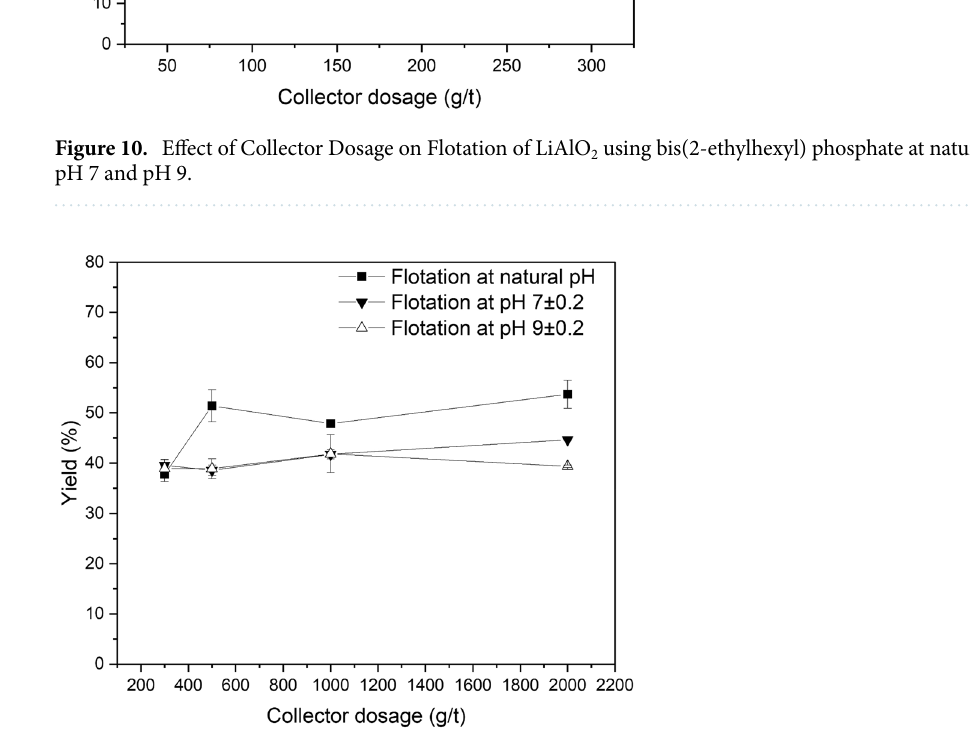
Figure 11. Effect of Collector Dosage on Flotation of Melilite s.s. using bis(2-ethylhexyl) phosphate.